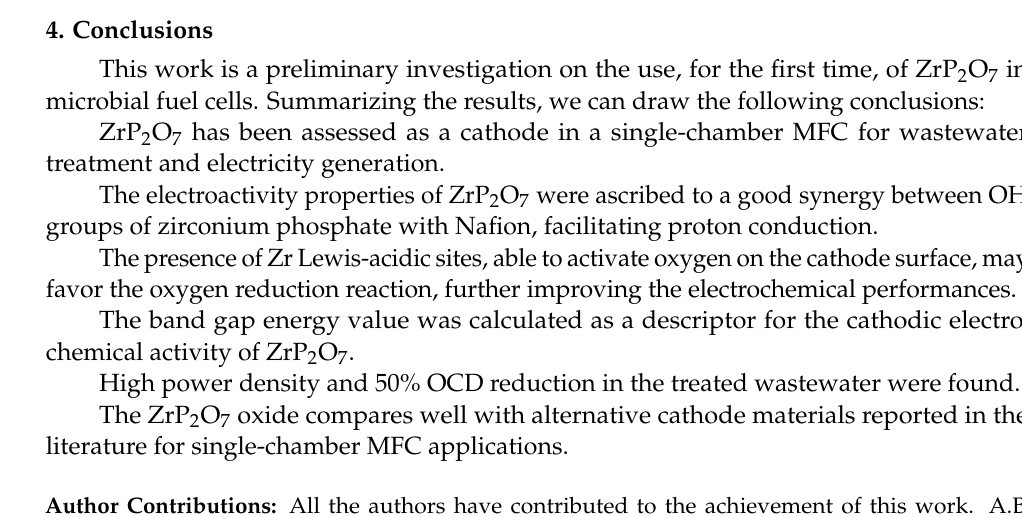
Figure 8. Cyclic voltammograms of ZrP 2 O 7 catalyst with various scan rates in ( A ) denoised water, ( B ) wastewater, ( C ) ferrocyanide solution, and ( D ) comparison of the three experiments at 100 mV/s.